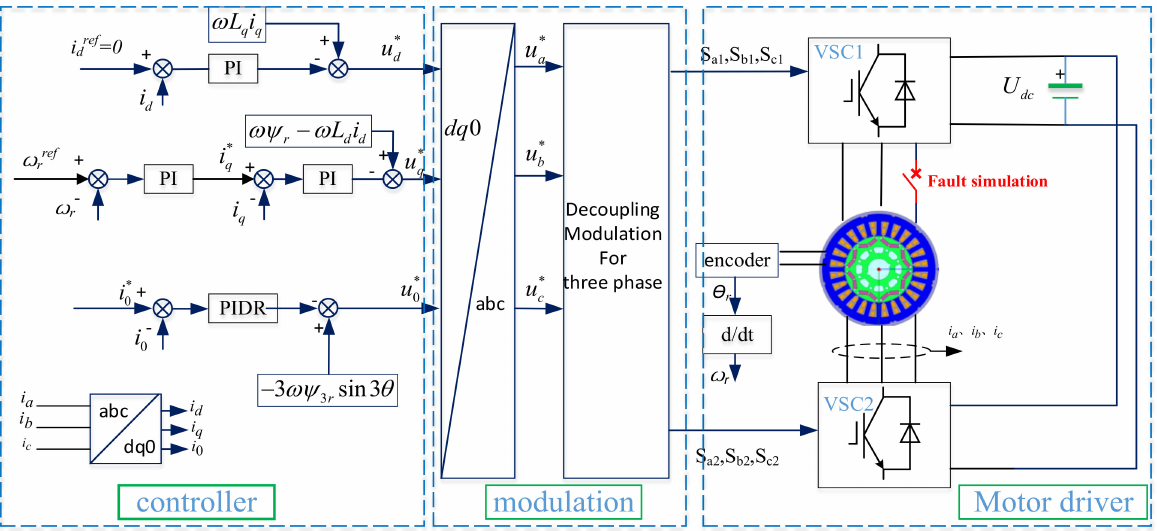
Figure 5. Zero-sequence current suppression method of common DC bus OW-PMSM based on PIDR under phase break